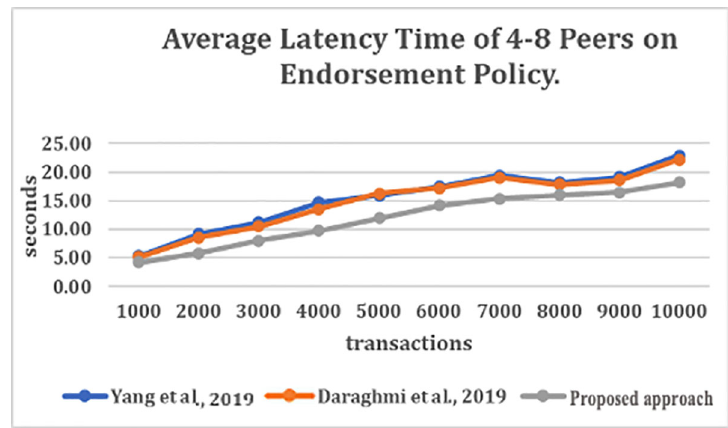
Figure 3. Average latency time of 4 – 8 peers on endorsement policy.